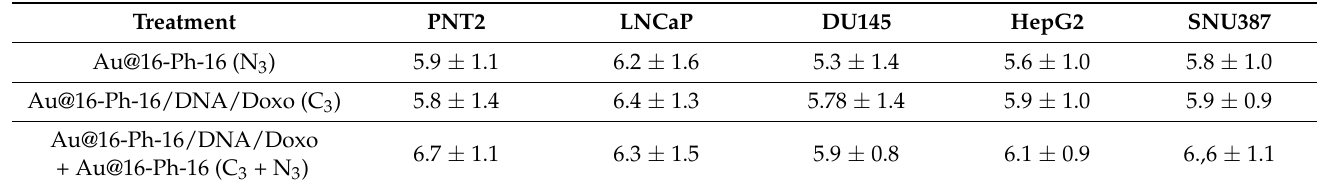
Table 3. Diameters of elements internalized in cells compatible with core AuNPs.